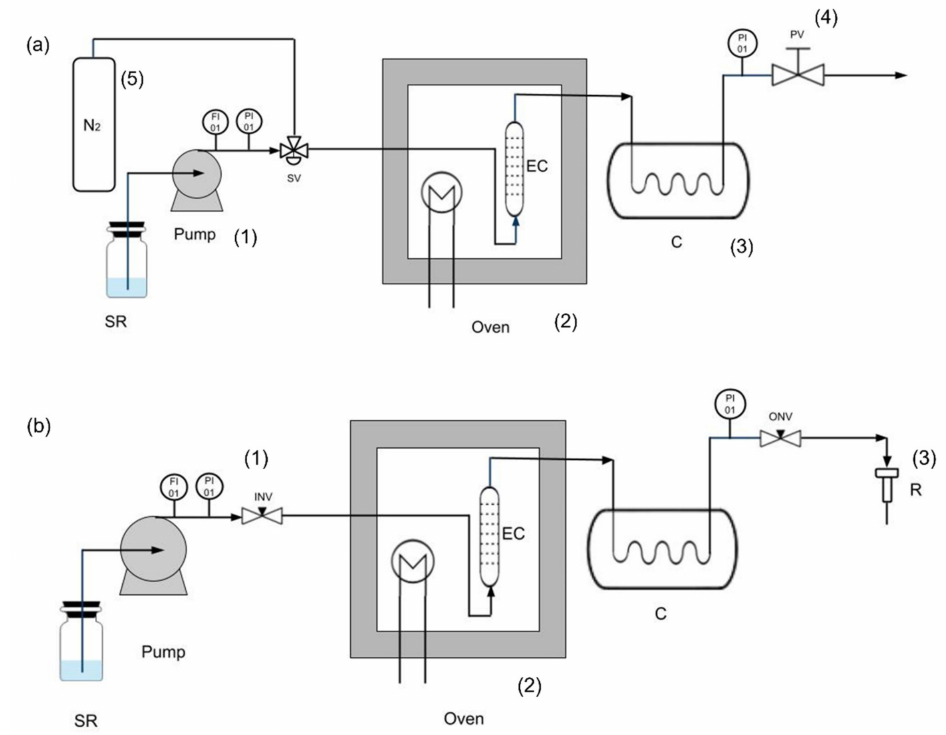
Figure 3. PLE system adapted from [27–29]. ( a ) Static mode; ( b ) Dynamic mode. SR, solvent reservoir; FI, flow indicator; PI, pressure indicator; SV, selecting valve; EC, extraction cell; C, cooler system; PV, pressure valve; INV, inlet needle valve; OV, outlet needle valve; R,